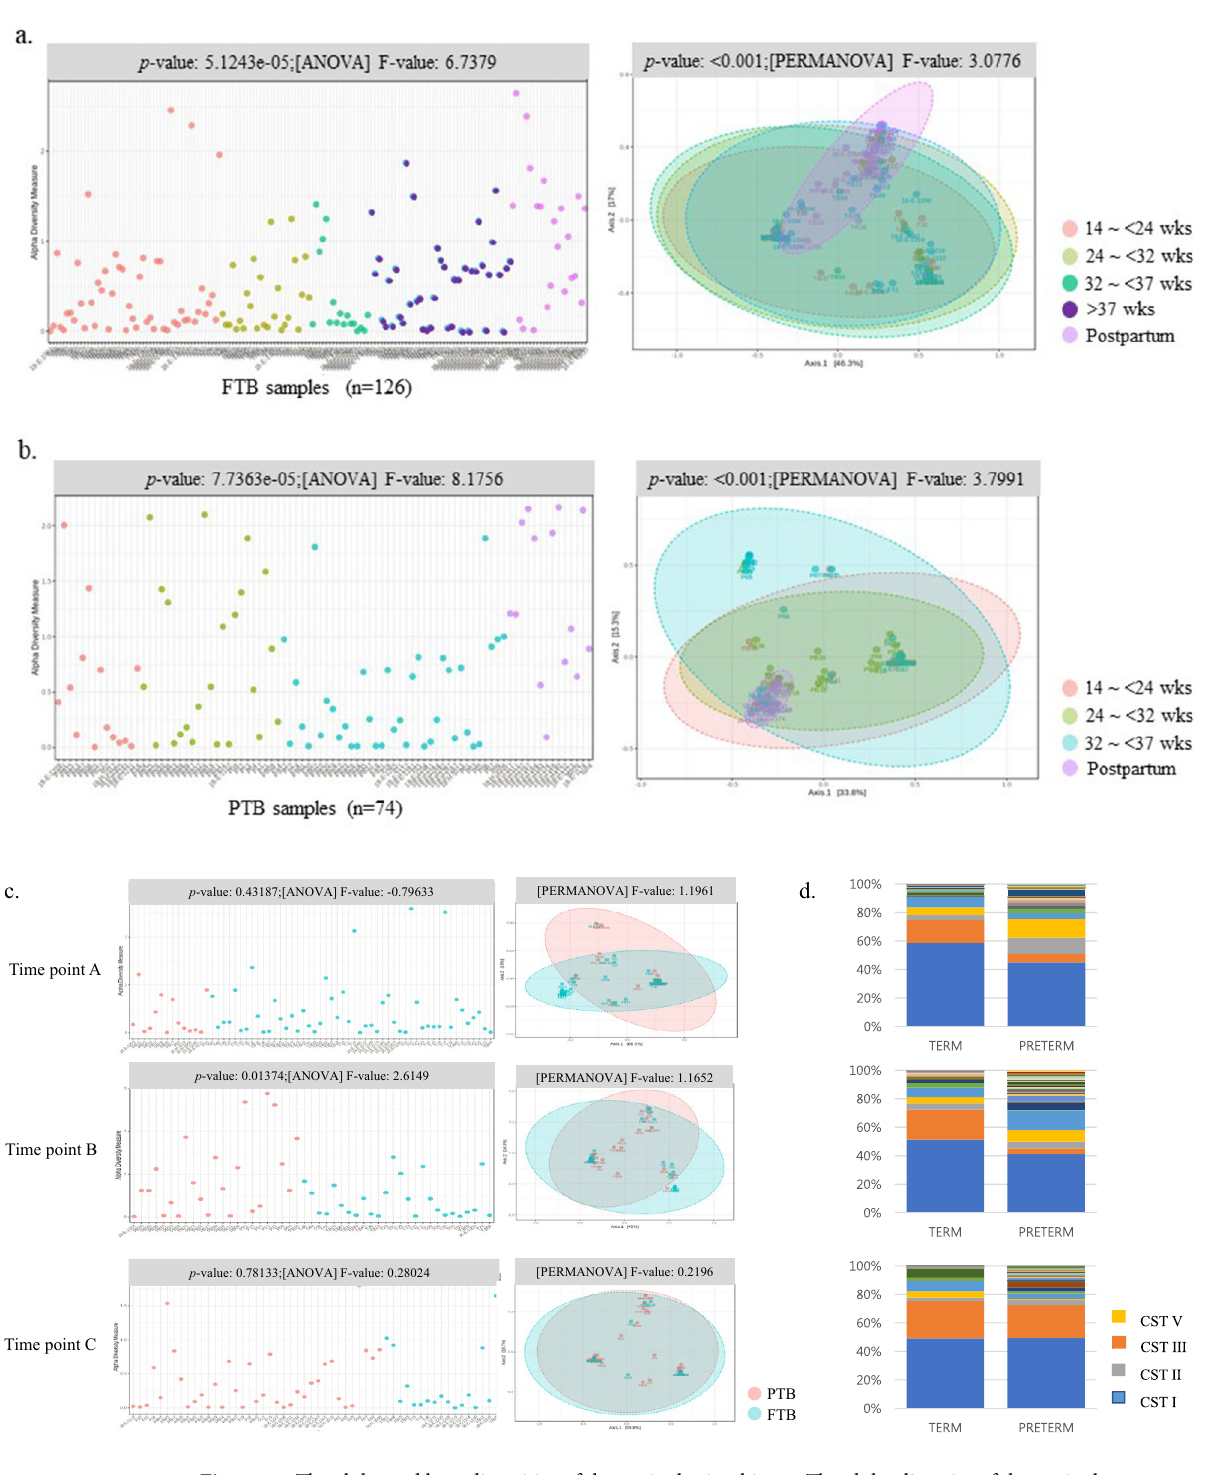
Figure 1. The alpha and beta diversities of the vaginal microbiome. The alpha diversity of the vaginal microbiome at each time point of sampling in women with ( a ) term delivery and ( b ) preterm delivery and ( c ) between FTB and PTB samples at each time point. ( d ) Bar graph of the vaginal microbiome at each time point. Based on the gestational age at sampling, we divided the samples into five groups: 56 at time point A (14–23 weeks), 43 at time point B (24–31 weeks), 54 at time point C (32–36 weeks). FTB Full-term birth, PTB Preterm birth, PP